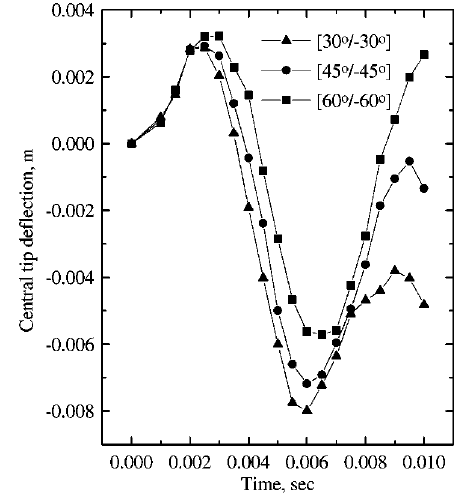
Fig. 7. Comparative central tip deflection versus time for 2-fold E-glass–Epoxy 2 layered folded plate with crank angle (cid:12) = 120 (cid:14) for various fibre angles (ref. Fig. 3) with L = 1 : 5 m and suddenly applied step load q = 1 : 0 (cid:2) 10 5 N/m 2